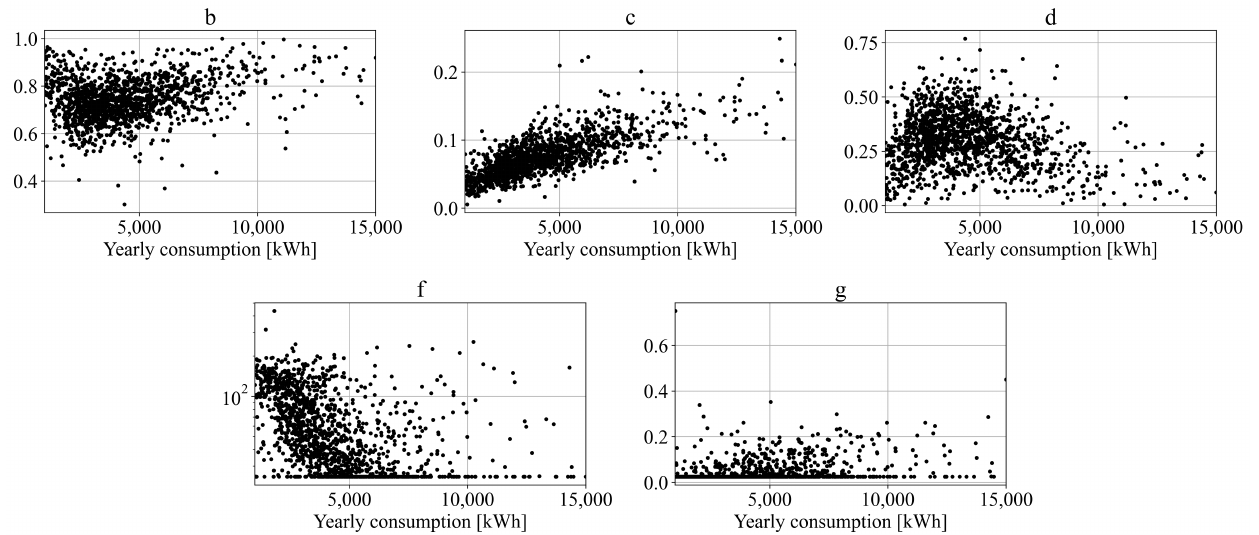
Figure 3. Scatterplots of the parameters included in Equation (2), plotted versus the yearly consumption.